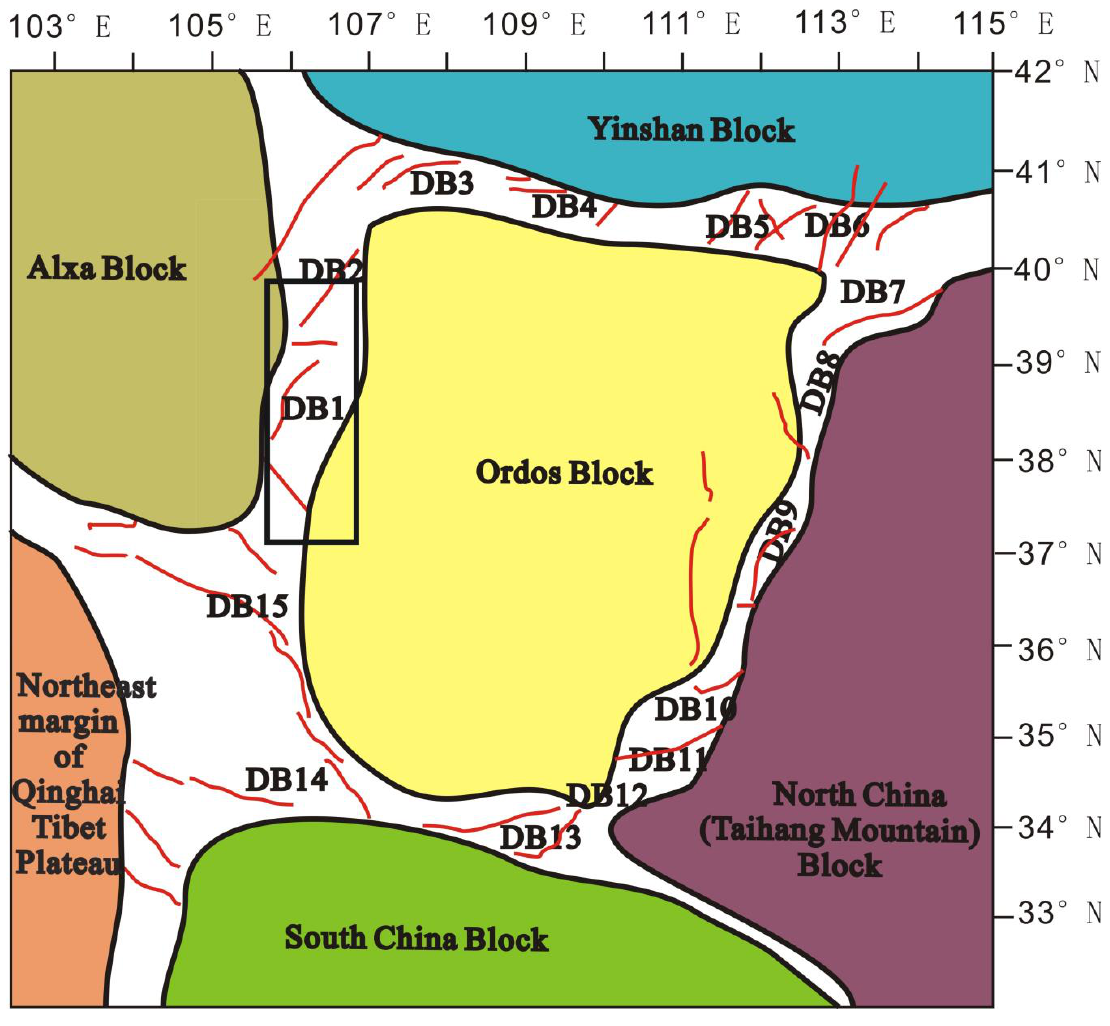
Figure 1. Distribution of Ordos Block and main blocks, basins and faults around it. The black box part is the study area. The black lines are the block boundaries, and red lines represent faults; DB1 —